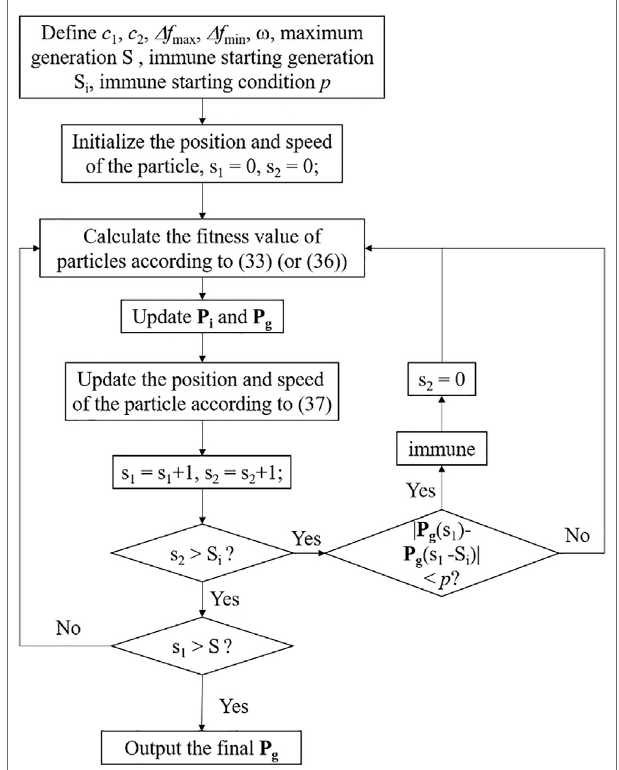
FIGURE 5 | Flowchart of the optimization.